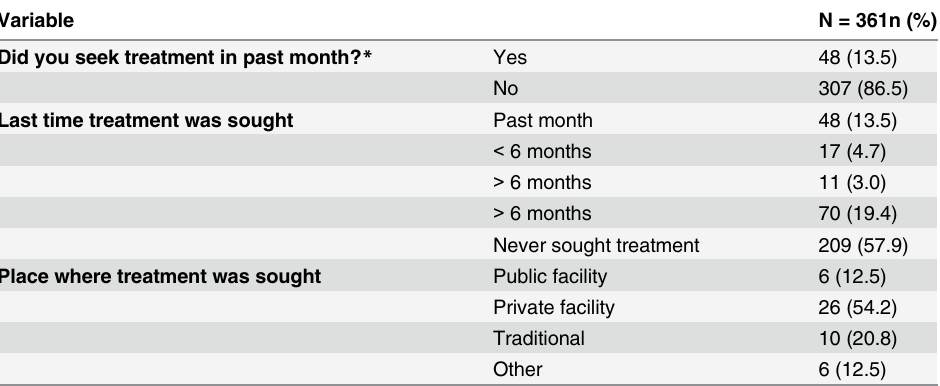
Table 3. Patients treatment seeking for manifestations.